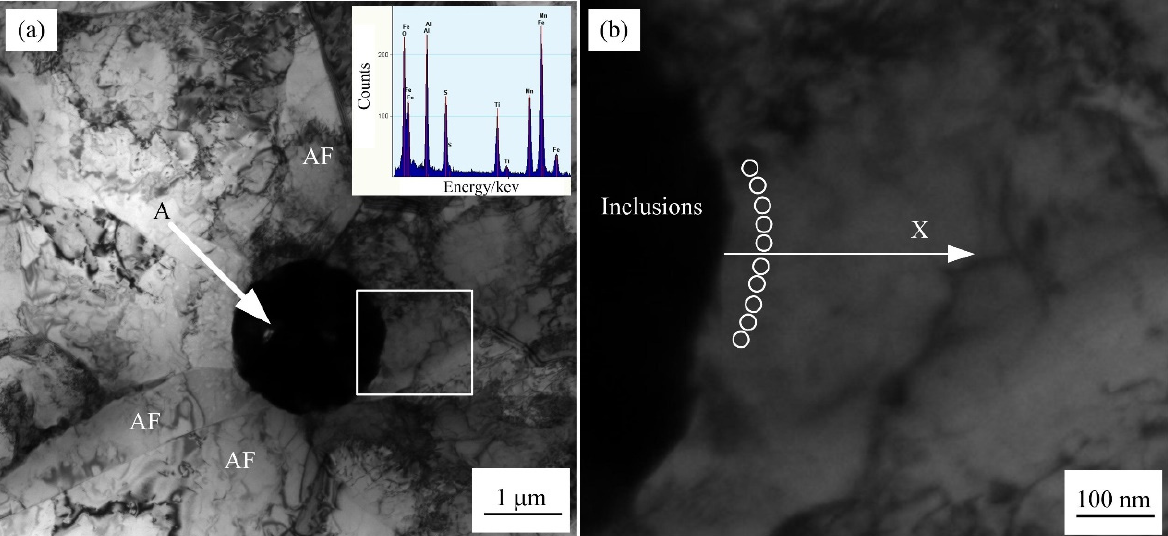
Figure 6. TEM morphology of inclusions in the weld metal at the cooling rate of 10 °C/s: ( a ) Original image with EDS and ( b ) locally magnified image.